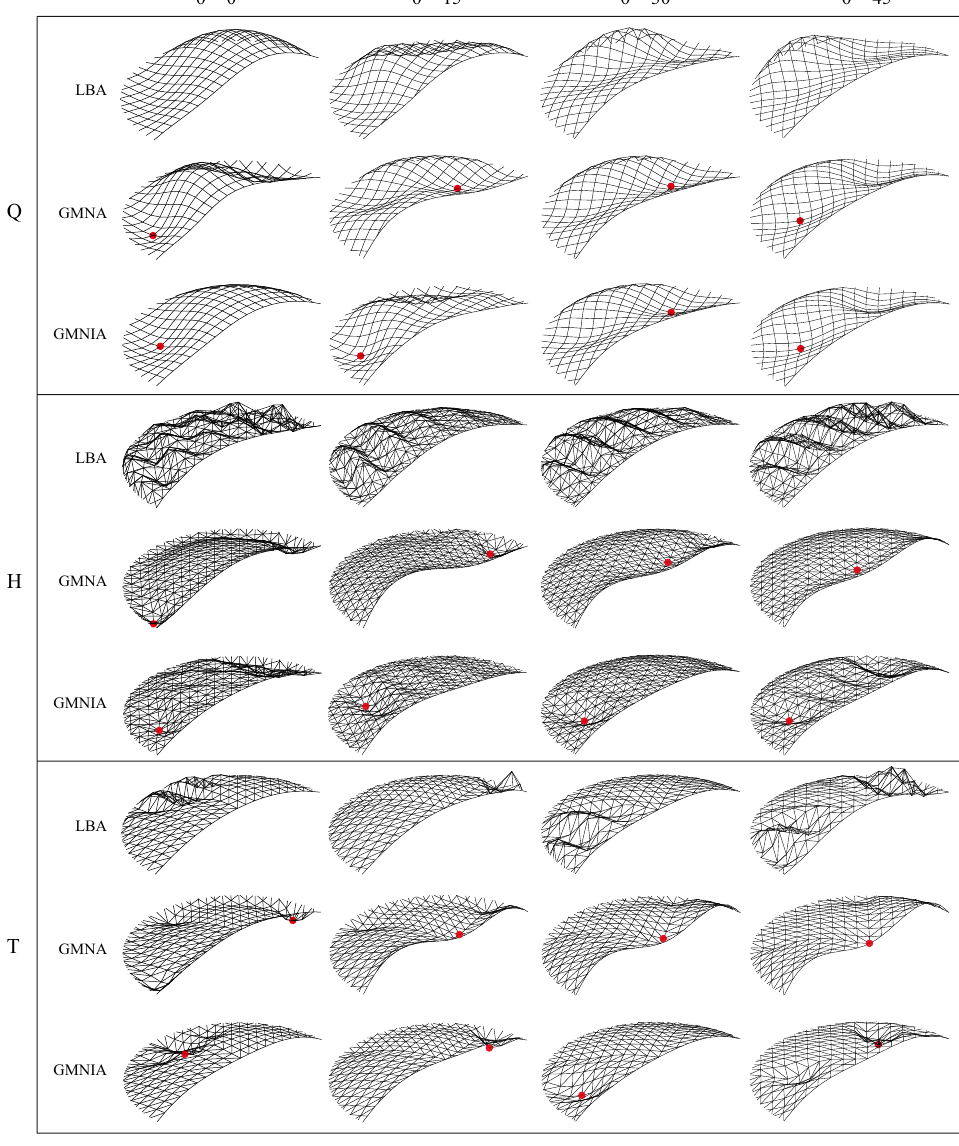
Figure 7: Buckling shapes (displacements normalised to 2